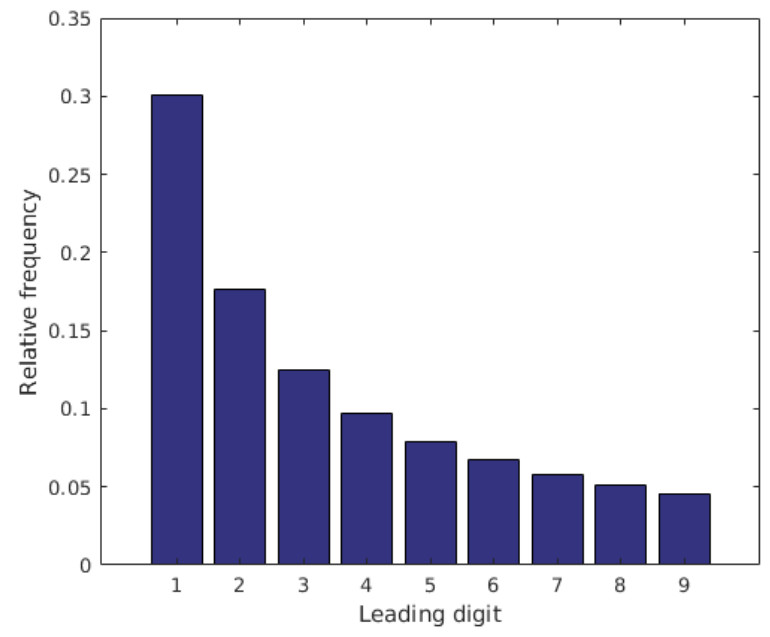
Figure 1. Illustration of Benford’s